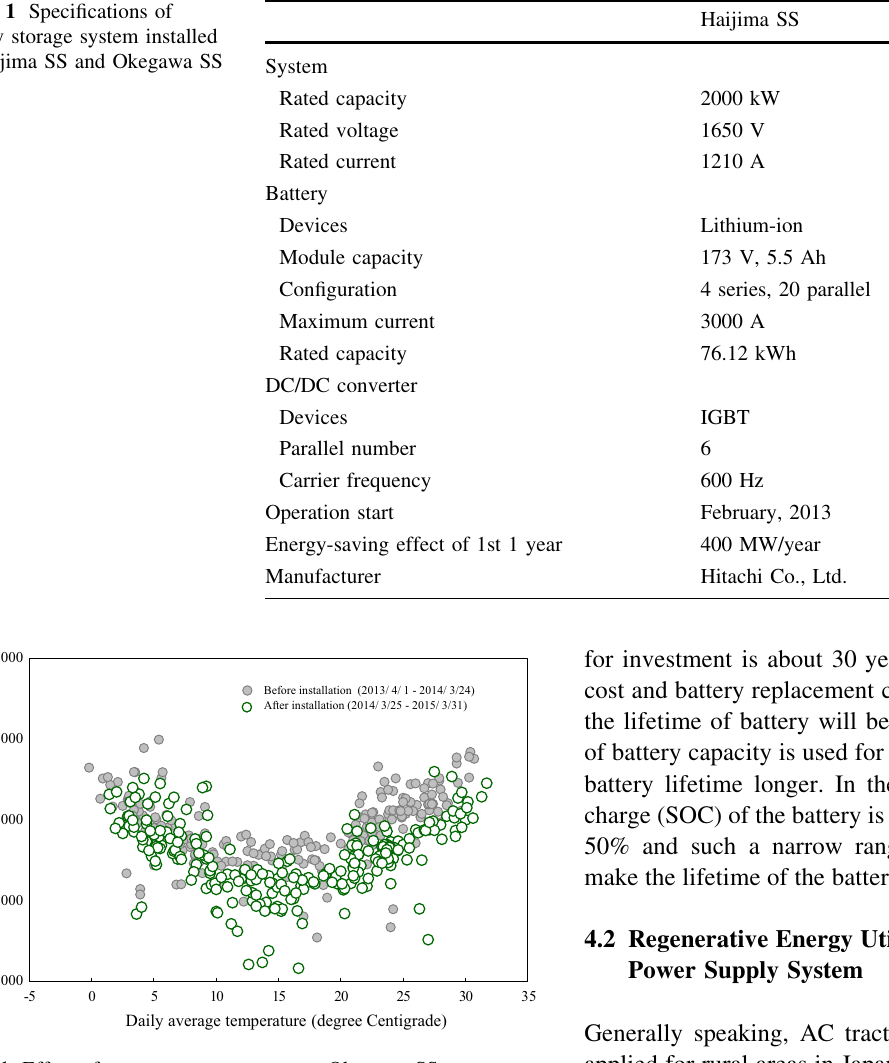
Fig. 11 Effect of energy storage system at Okegawa SS